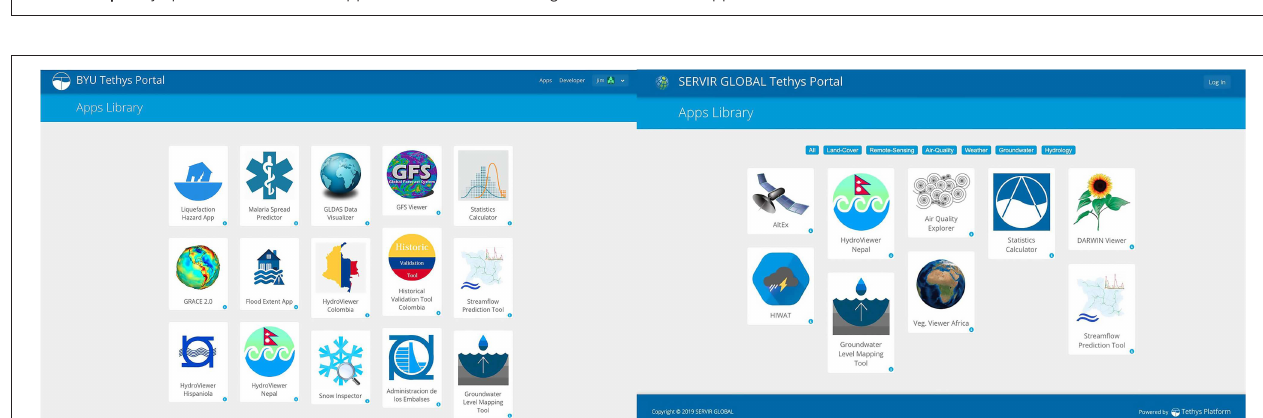
FIGURE 4 | Tethys platform cloud-based app architecture for delivering SERVIR decision support tools.